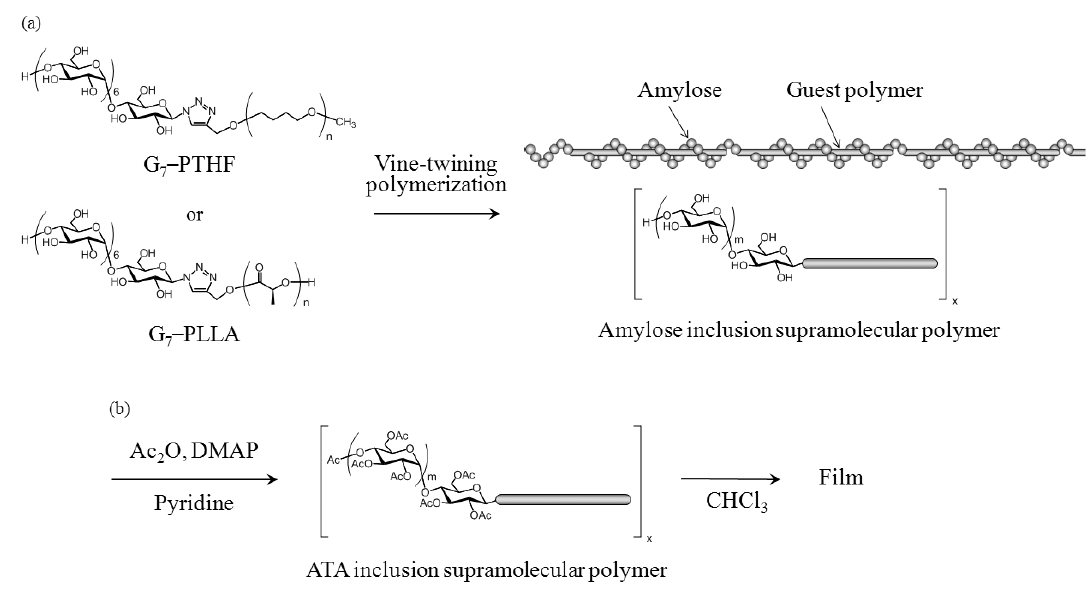
Figure 2. Preparation of: ( a ) amylose triacetate (ATA) inclusion supramolecular polymers and ( b ) their films. DMAP: N,N ‐ dimethyl ‐ 4 ‐ aminopyridine.